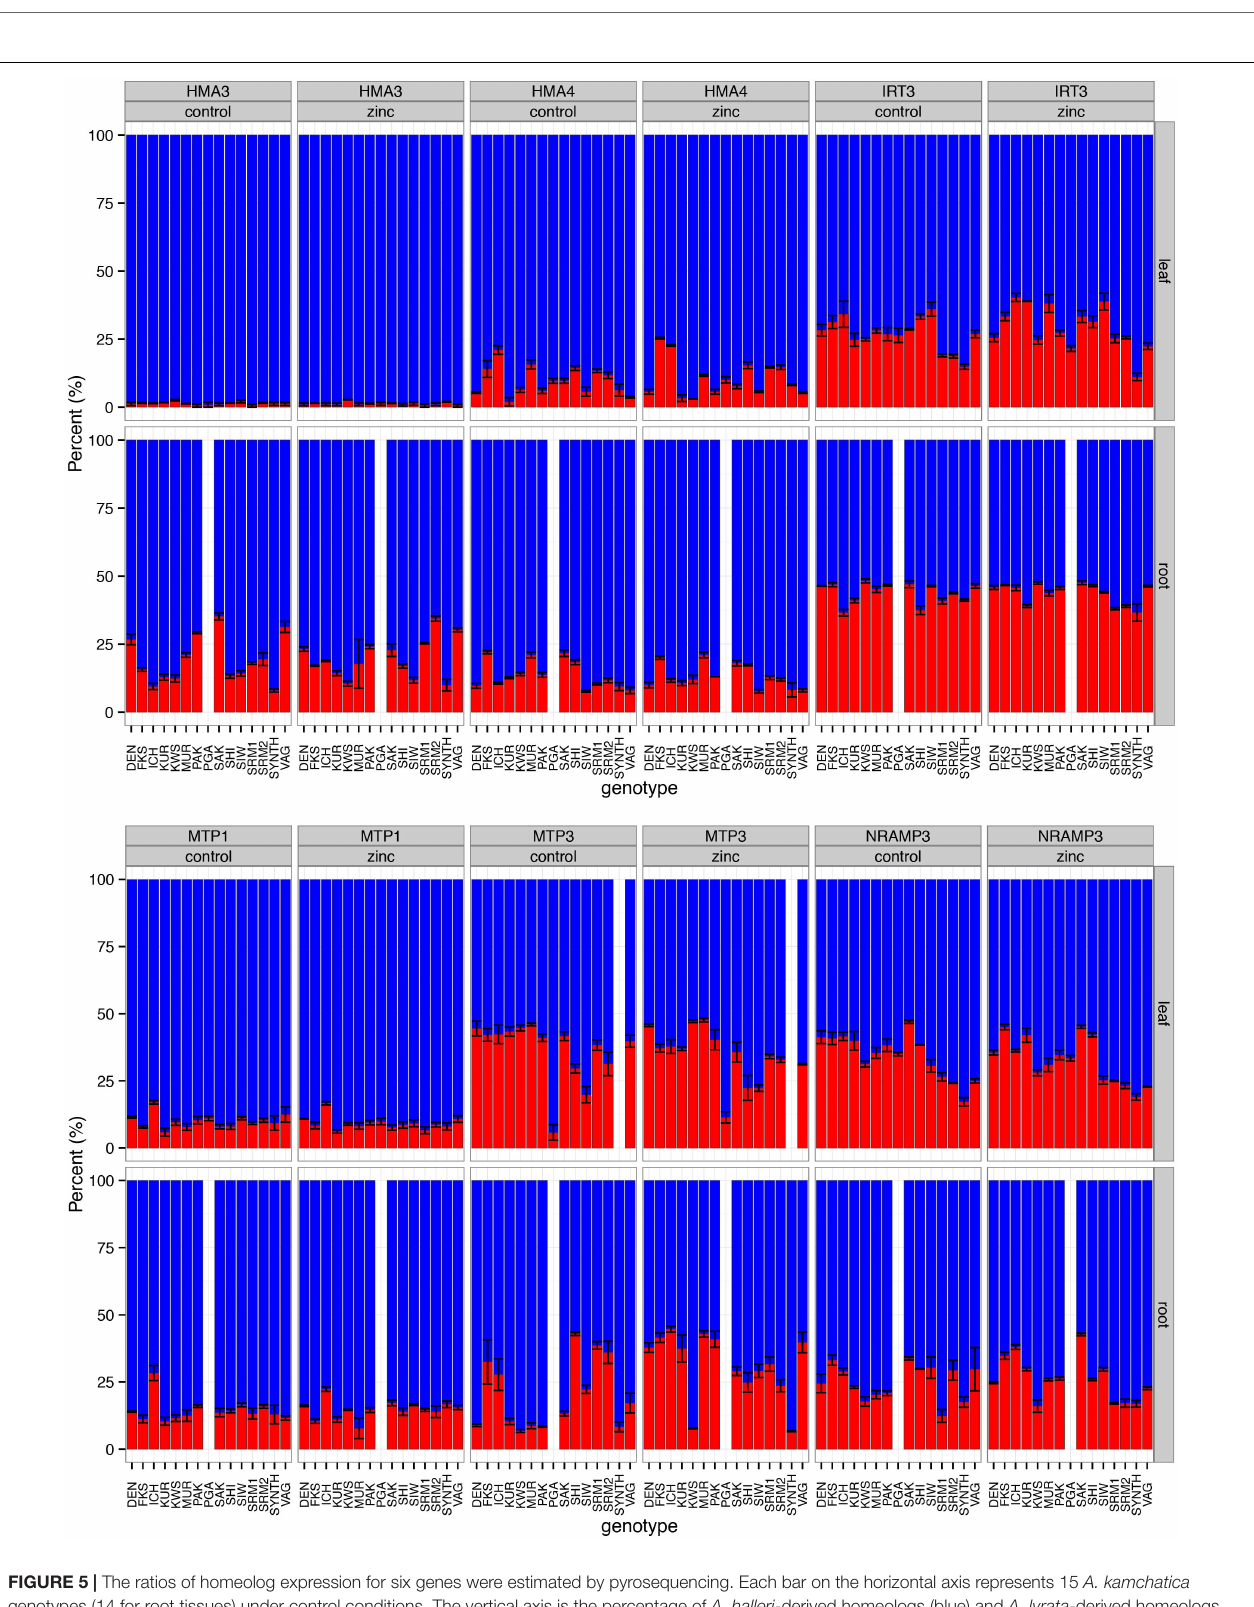
FIGURE 5 | The ratios of homeolog expression for six genes were estimated by pyrosequencing. Each bar on the horizontal axis represents 15 A. kamchatica genotypes (14 for root tissues) under control conditions. The vertical axis is the percentage of A. halleri -derived homeologs (blue) and A. lyrata -derived homeologs (red). For each gene, we estimated expression ratios under control (1 µ M Zn) and zinc-treatment (500 µ M Zn) conditions; plants were sampled 48 h after the administration of the treatment. Root data were not collected for the PGA genotype (data used to plot bar graphs can be found in Supplementary Table 10 ).